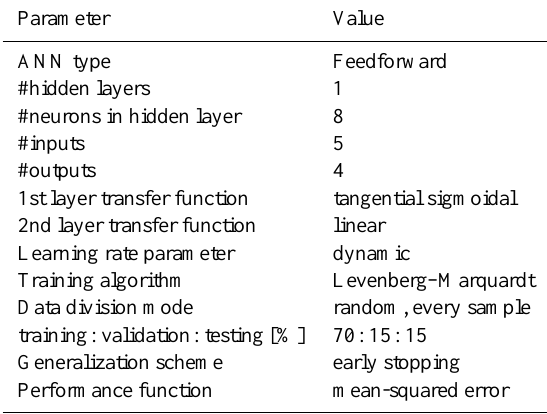
Table A3. Default PhytoANN parameters chosen for this